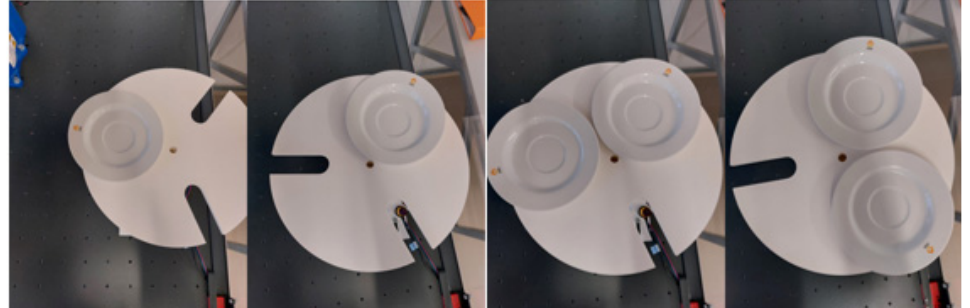
Figure 7. Drying table rotations. Source: (Own).